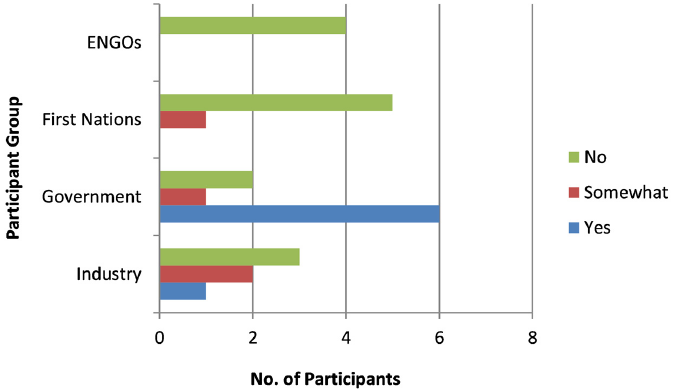
Figure 1. Distribution of completed education, represented as a proportion of categorized group.